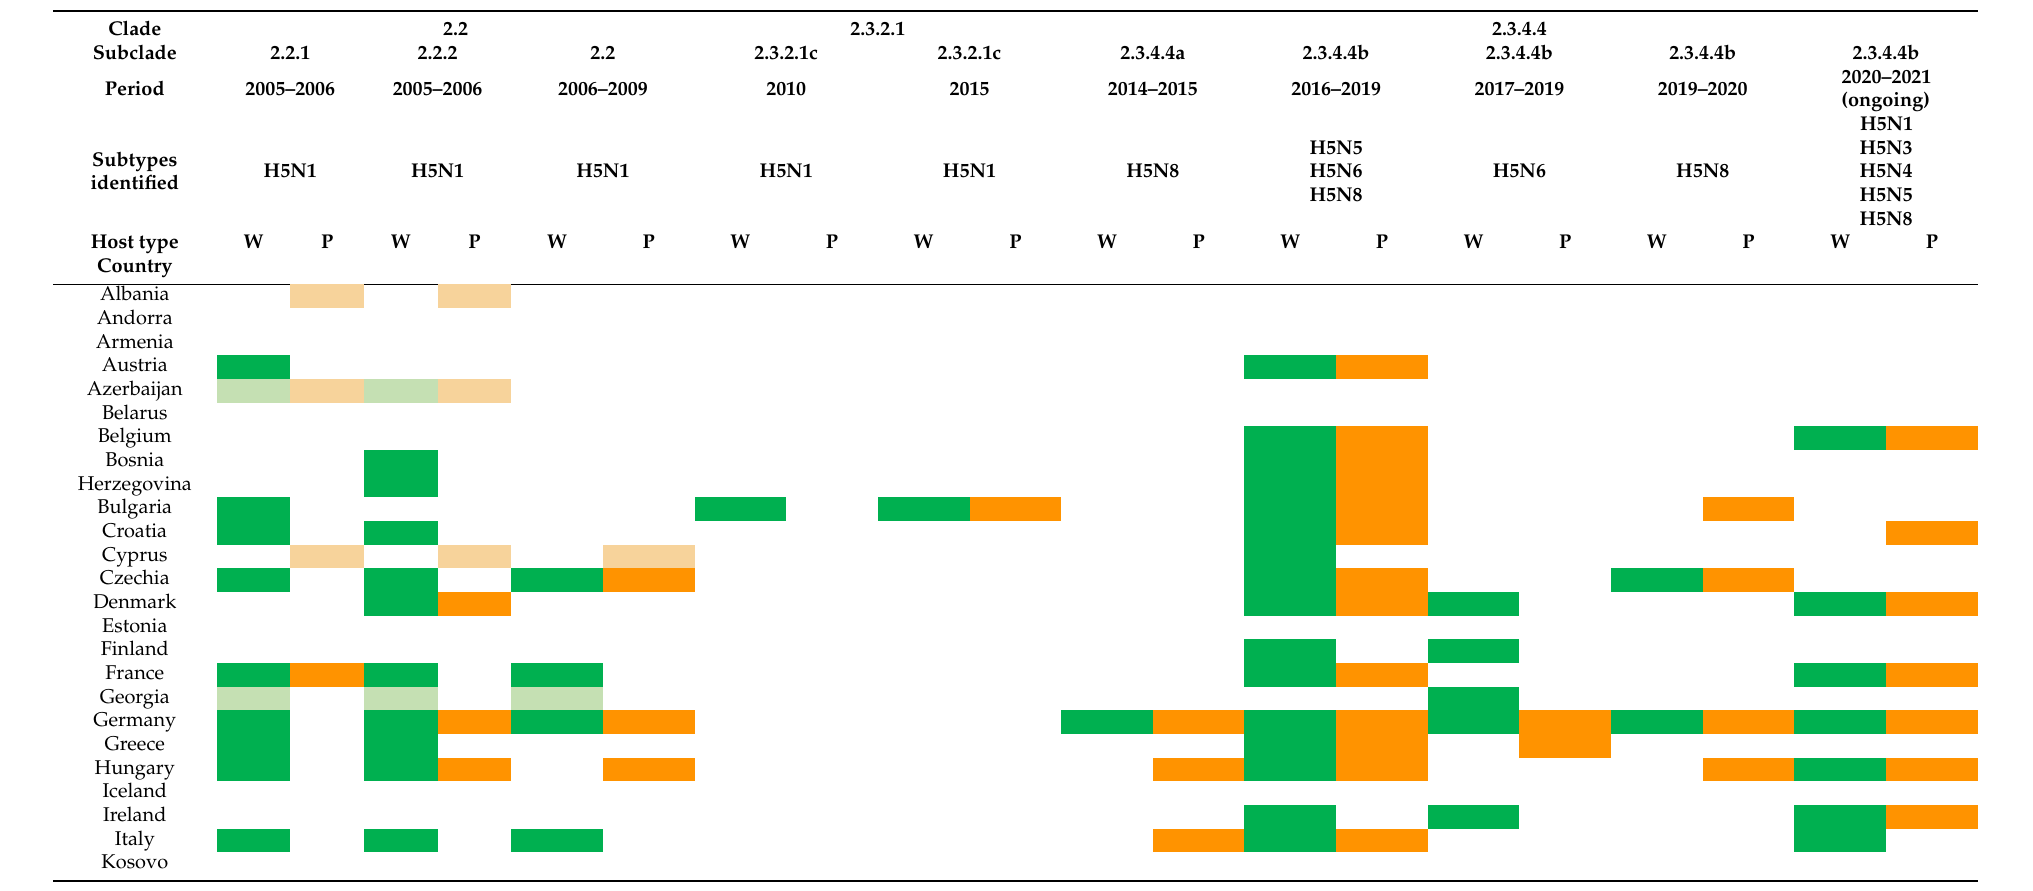
Table 1. Highly pathogenic avian influenza H5 GsGd virus incursions into Europe, 2005–2020. P, poultry; W, wild birds. Green, viruses detected in wild birds; orange, viruses detected in poultry; light green, clade 2.2 viruses detected in wild birds and subclade unknown; light orange, clade 2.2 viruses detected in poultry and subclade unknown. References used